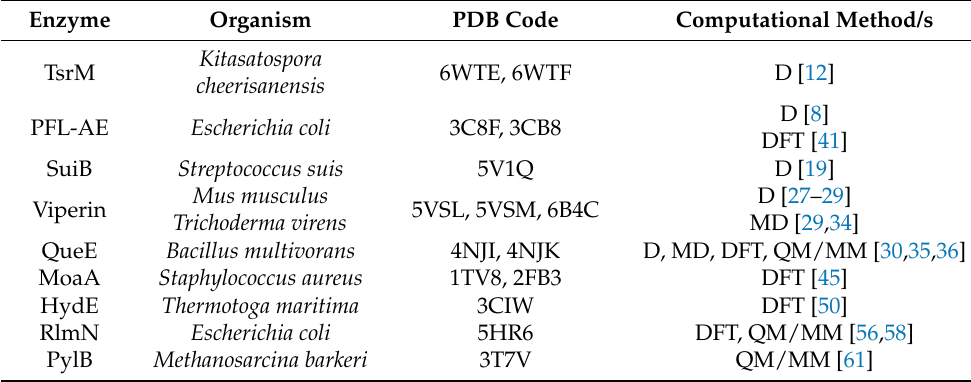
Figure 6. Mechanistic dynamics of RlmN and PylB elucidated by hybrid computational methods. ( A ) QM/MM calculations of RlmN indicate that deprotonation of the target carbon likely precedes cleavage of the tRNA-Cys crosslink. ( B ) Study of the PylB mechanism via hybrid methods led to the proposal that reorientation of the aminobutene intermediate (indicated by the red arrow) prior to recombination facilitates re-abstraction of the H atom from dAdoH. Table 1. Summary of computational approaches applied to rSAM enzymes discussed herein.